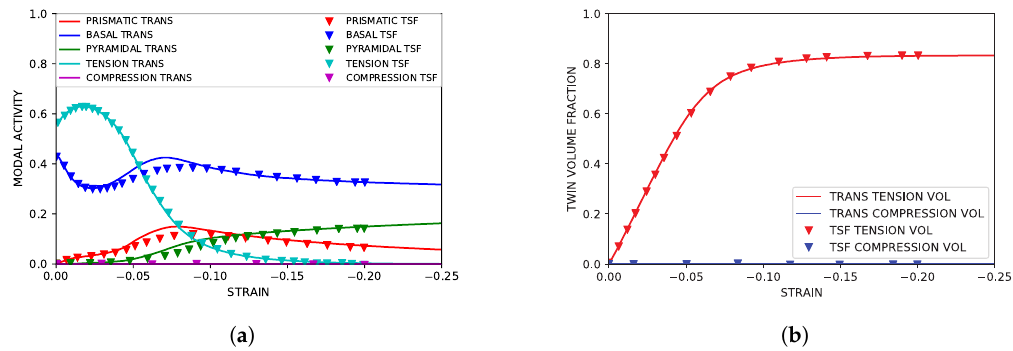
Figure 7. Simulated parent slip and primary twinning activity under IPC compression compared to simulated results from Oppedal et al. [14]. ( a ) Simulated modal contributions vs. strain. ( b ) Simulated twin volume growth vs. strain.